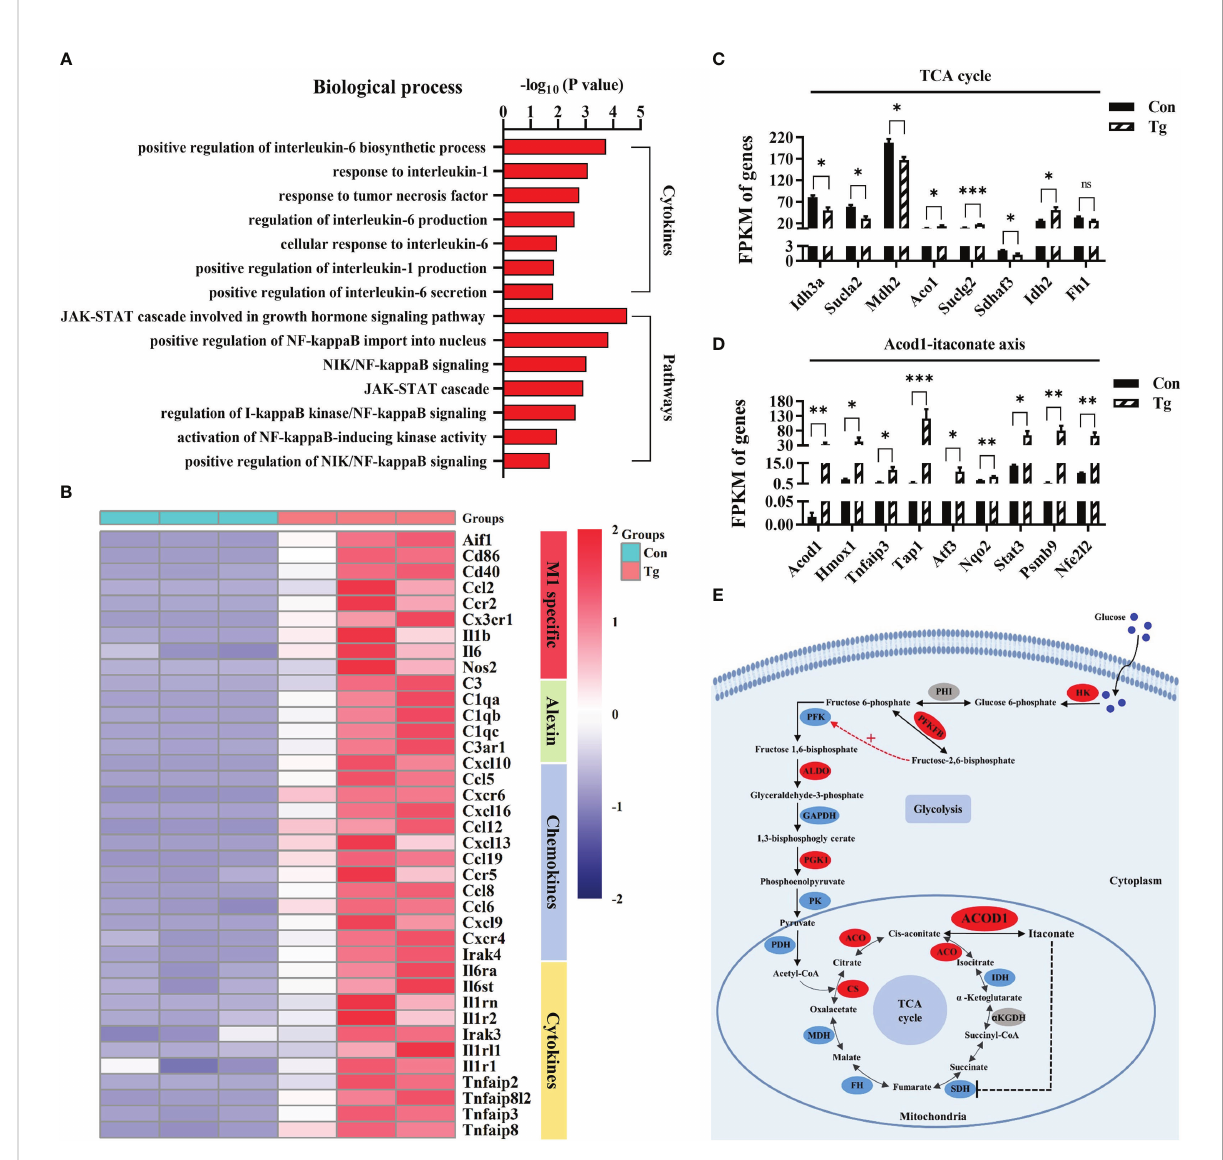
FIGURE 3 T.gondii chronicinfectiontriggersextensive neuroin fl ammation alongwithdisorderof theAcod1/itaconateaxis inthehippocampusof mice. (A) The biological processesassociated withcytokinesandin fl ammatorypathwaysareupregulatedin T. gondii infectedmice. (B) Heatmapdemonstratingthe relativeexpressionofcoregenes relatedtoM1speci fi c,alexin,chemokinesandcytokinesinthe enrichmentplot ( n =3)areupregulatedin